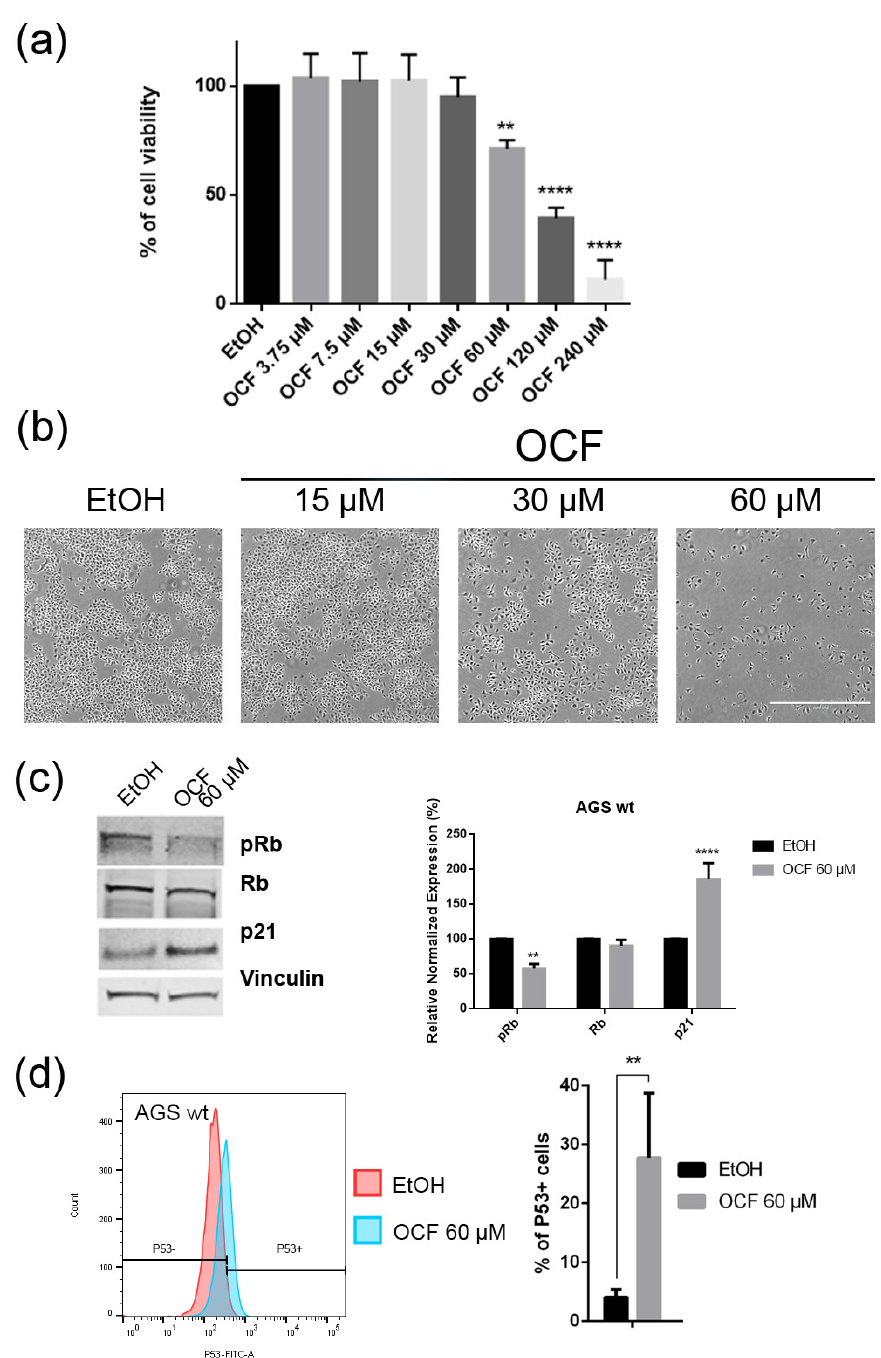
Figure 2. Effects of different doses of OCF on AGS wt cells. AGS wt cells, treated for 72 h with vehicle or different doses of the OCF, were analyzed through a MTT assay ( a ); pictures were obtained with an inverted microscope at 4× magnification ( b ); representative western blot analysis of phosphor-Rb (p-Rb), Rb, p21 and vinculin levels in the AGS wt treated with vehicle or 60 µM dose of the OCF for 24 h and the corresponding densitometry ( c ). Flow cytometry plots for the p53 staining and the corresponding histograms ( d ). Results of the representative experiments are shown. ** p < 0.01, **** p < 0.0001. ( a ) One-way ANOVA Dunnett’s multiple comparisons test; ( c,d ) Two-way ANOVA Sidak’s multiple comparisons test.